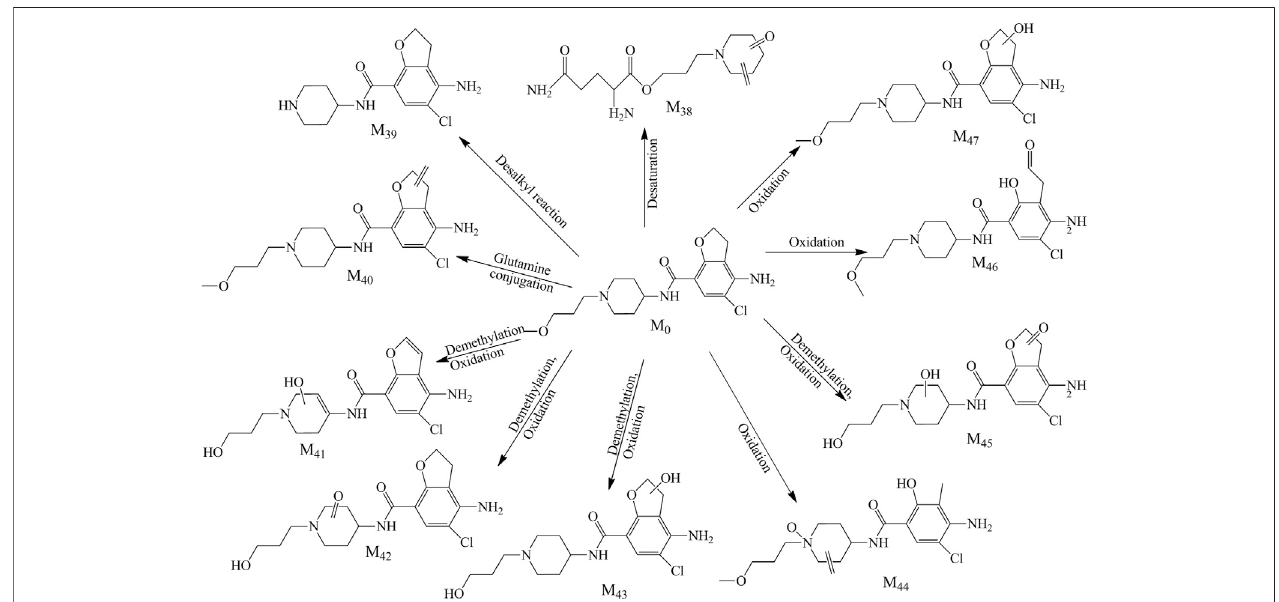
FIGURE 5 | Proposed metabolite pathway of prucalopride in the feces.